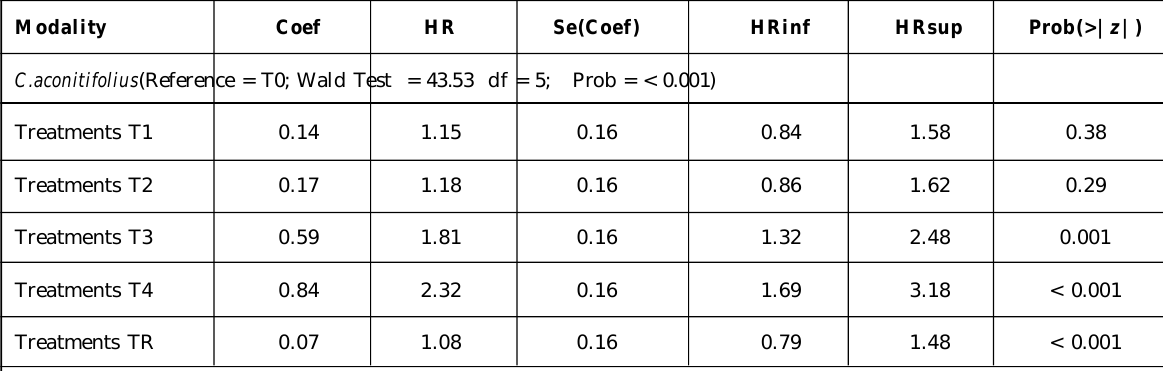
Table 2 : Result of cox model applied to mortality rate of C. maculatus under the effect of ethanolic extract of C. aconitifolius